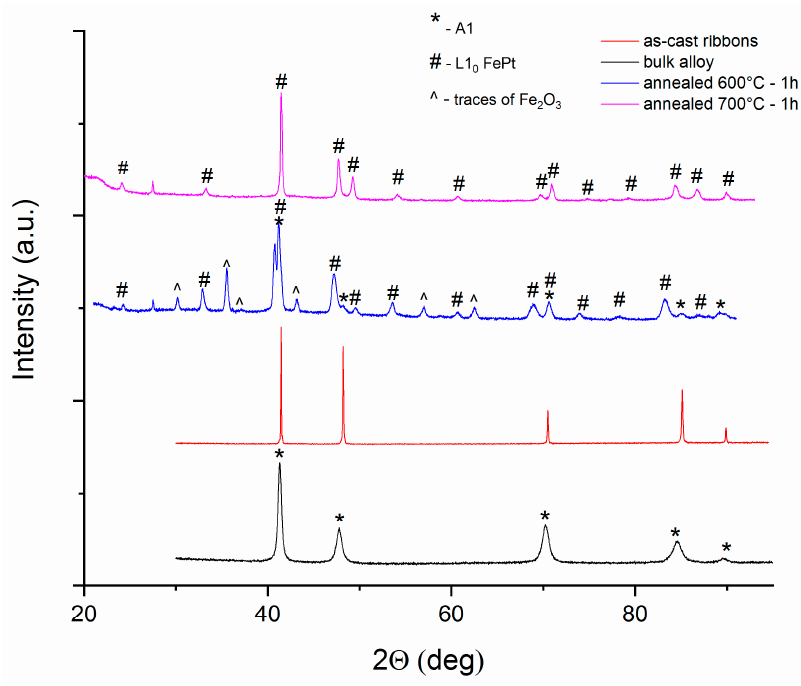
Figure 2. X-ray diffractogram of Fe 57 Mn 8 Pt 35 in bulk state, as cast ribbons and ribbons annealed at 600 °C-1 h and 700 °C-1 h.